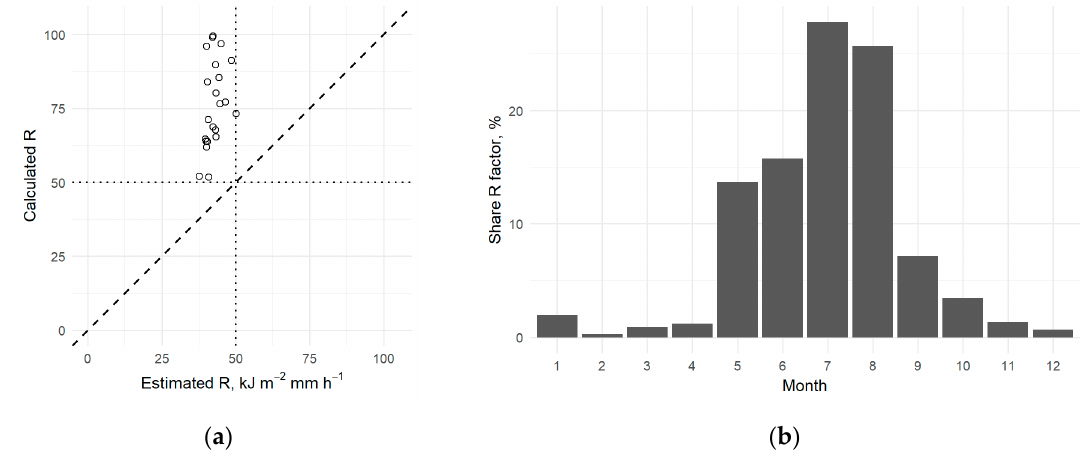
Figure 2. Variability of rainfall erosivity: ( a ) R factors estimated with the existing regression model were lower and less variability than the calculated R factors (1:1 line = perfect model agreement). The fixed R value of 50 kJ m − 2 mm h − 1 used for the current state erosion map corresponds to the upper boundary of the estimated R factors (vertical line) and the lower boundary of the calculated R factors (horizontal line). Both, calculation and estimation of R factors according to the German norm DIN; ( b ) average intra-annual distribution of the rainfall erosivity. Rainfall from October to April was far less erosive than summer rainfall and therefore not considered in the revised regression models for R factors in